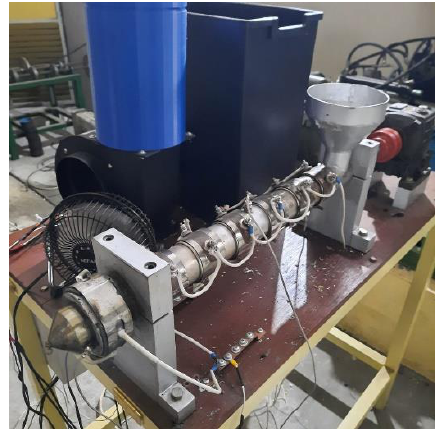
Figure 3. Single screw extruder machine.